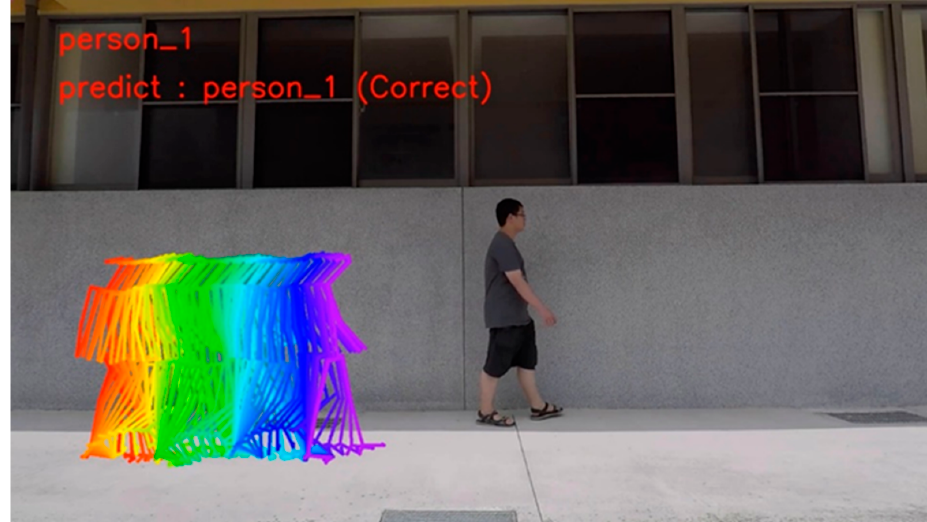
Figure 9. Identity recognition.